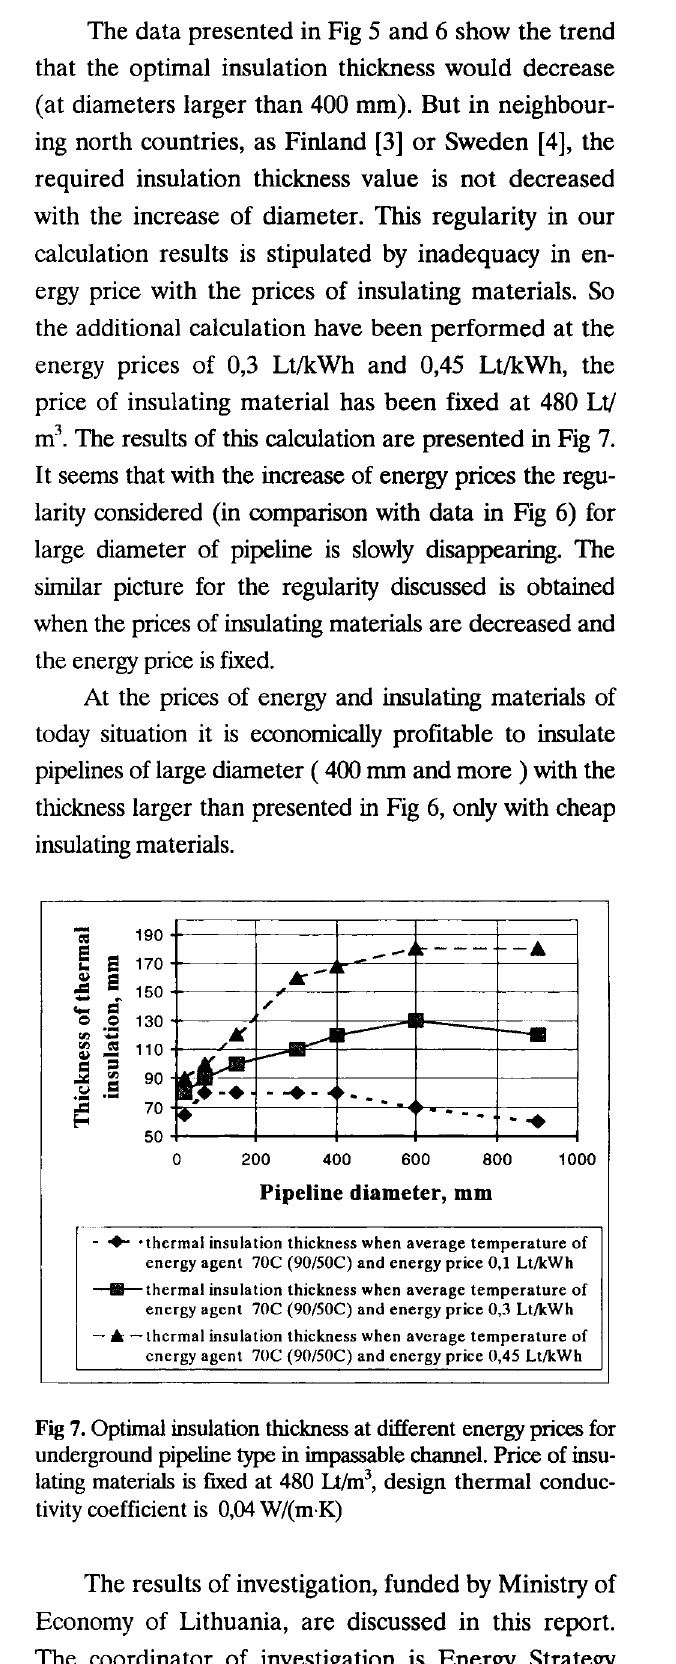
Fig 7. Optimal insulation thiclmess at different energy prices for underground pipeline type in impassable channel. Price of insu lating materials is fixed at 480 Wm 3 , design thermal conduc tivity coefficient is 0,04